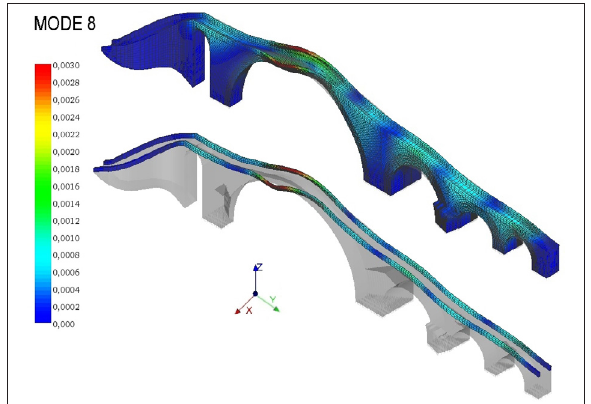
Figure 15. The eighth mode shape calculated via the NOSA-ITA- CA